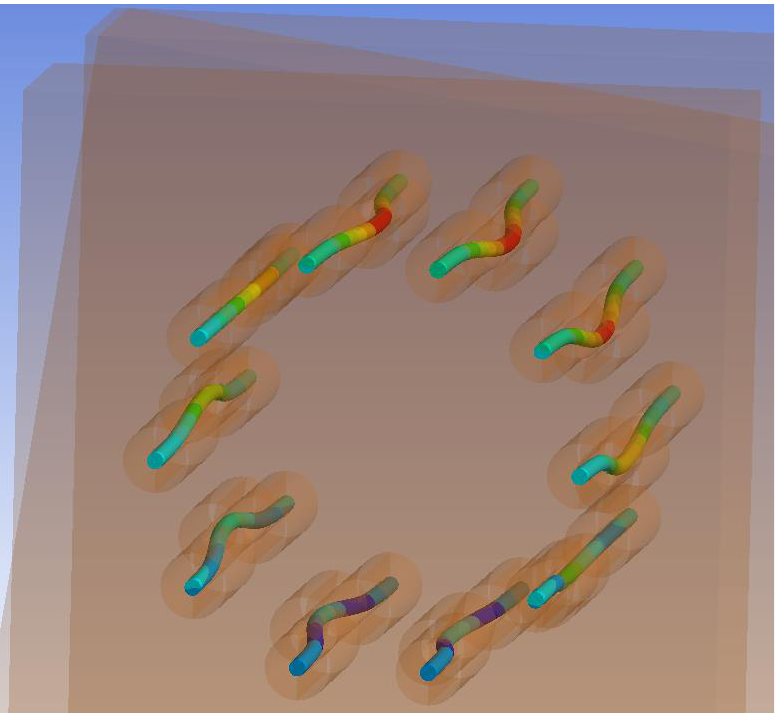
Figure 27. Overall deformation of fasteners (fully threaded screws) for Experiment B.